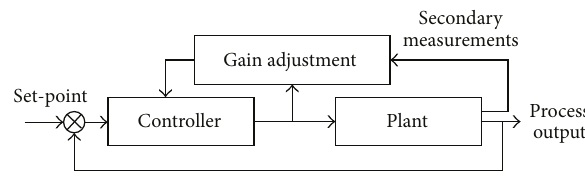
Figure 2: Neural scheduled adaptive control